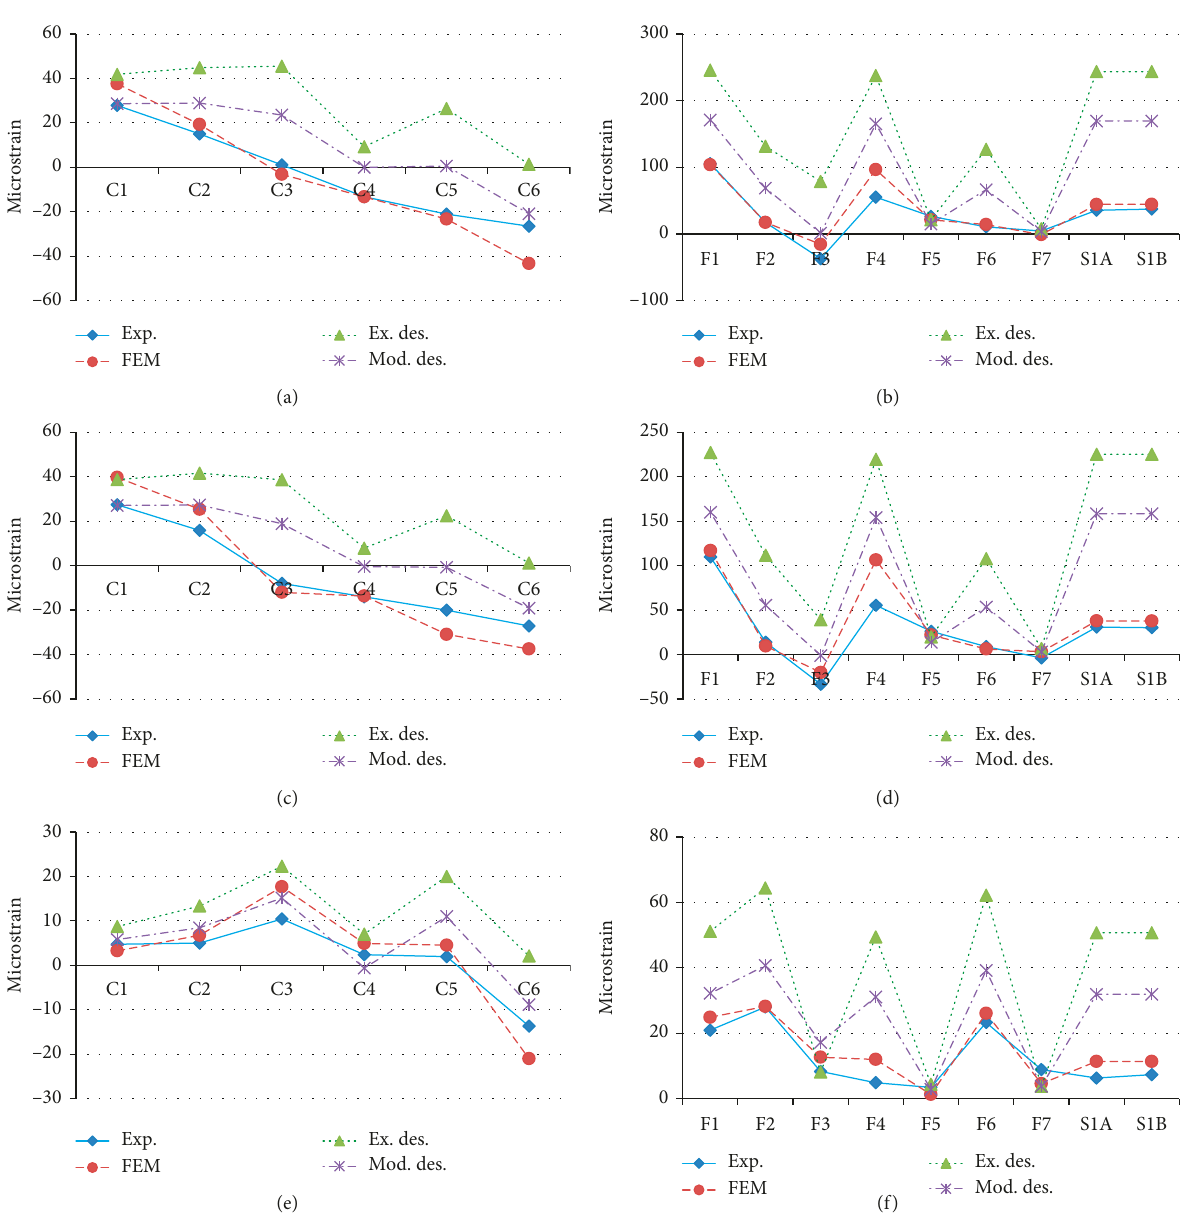
Figure 5: Strain values due to the three stops (stage 3). (a) Concrete VWSGs (stop 1). (b) FRP and steel gauges (stop 1). (c) Concrete VWSGs (stop 2). (d) FRP and steel gauges (stop 2). (e) Concrete VWSGs (stop 3). (f) FRP and steel gauges (stop